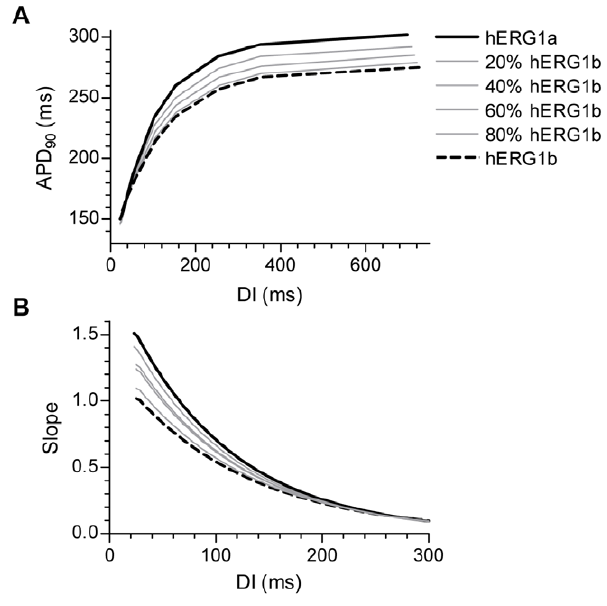
Figure 6. Restitution slope is modulated by the relative abundance of hERG1a and hERG1b. A, Single-cell action potential restitution. The restitution curves were obtained using an S1-S2 restitution protocol measured at a BCL of 1000 ms. The action potential duration (APD 90 ) is plotted as a function of the diastolic interval (DI). The transition rates of hERG1 channel activation ( a 3 ), deactivation ( b 3 ) and recovery from inactivation ( b 4 ) were modified to represent a gradual increase in the relative abundance of hERG1b (see table S2 for details). B, The slopes of the restitution curves were calculated by differentiation of single-exponential functions fitted to the curves in A and plotted as a function of DI.